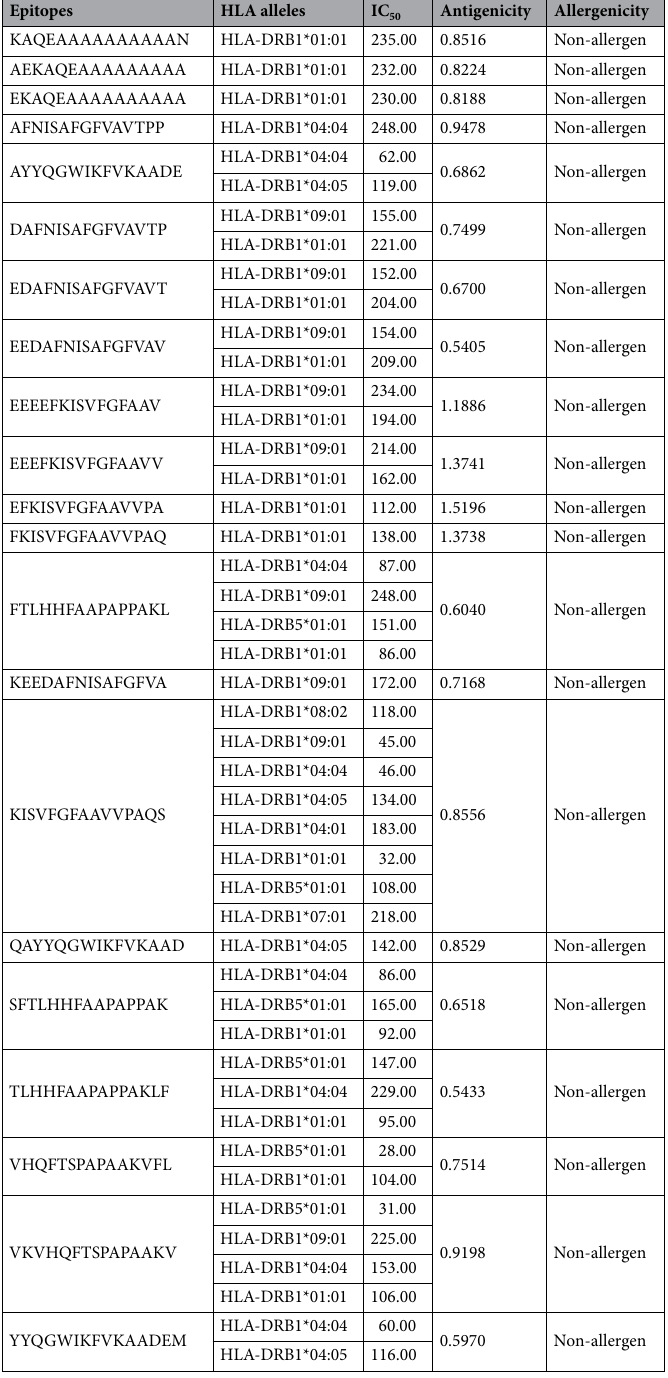
Table 3. Final predicted CD4 + T-cells epitopes, 100 overlapped with CD8 + T cell epitopes and interacting with different MHC-II